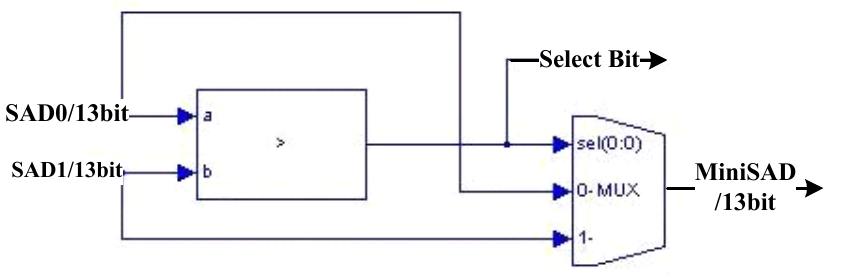
Figure 6. Basic Comparison Element of the DS Module.